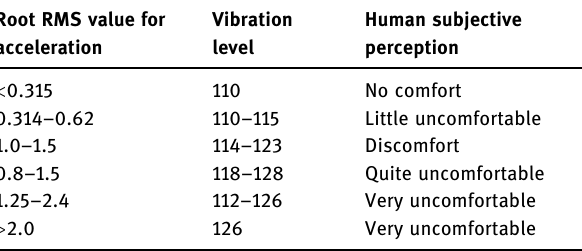
Table 1: The relationship between vibration level and root mean square value of acceleration and people ’ s subjective feeling Root RMS value for acceleration